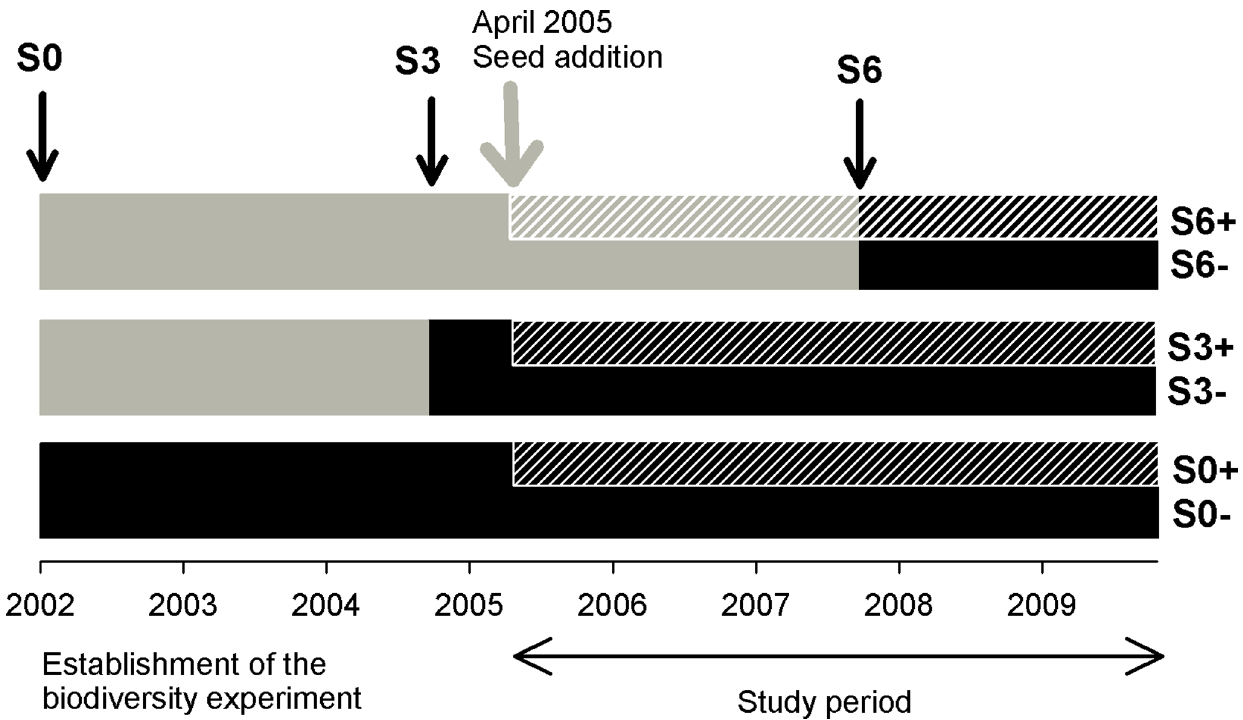
Figure 1. Summary of studied colonization period 6 seed addition treatments across initial species-richness levels. Vertical arrows indicate the time, when weeding was stopped in different treatments: (S0 2 ) = never weeded, no seed addition, (S0 + ) = never weeded, seed addition (2005), (S3 2 ) = cessation of weeding after three years (2004), no seed addition, (S3 + ) = cessation of weeding after three years (2004), seed addition (2005), (S6 2 ) = cessation of weeding after six years (2007), no seed addition, and (S6 + ) = cessation of weeding after six years (2007), seed addition (2005).